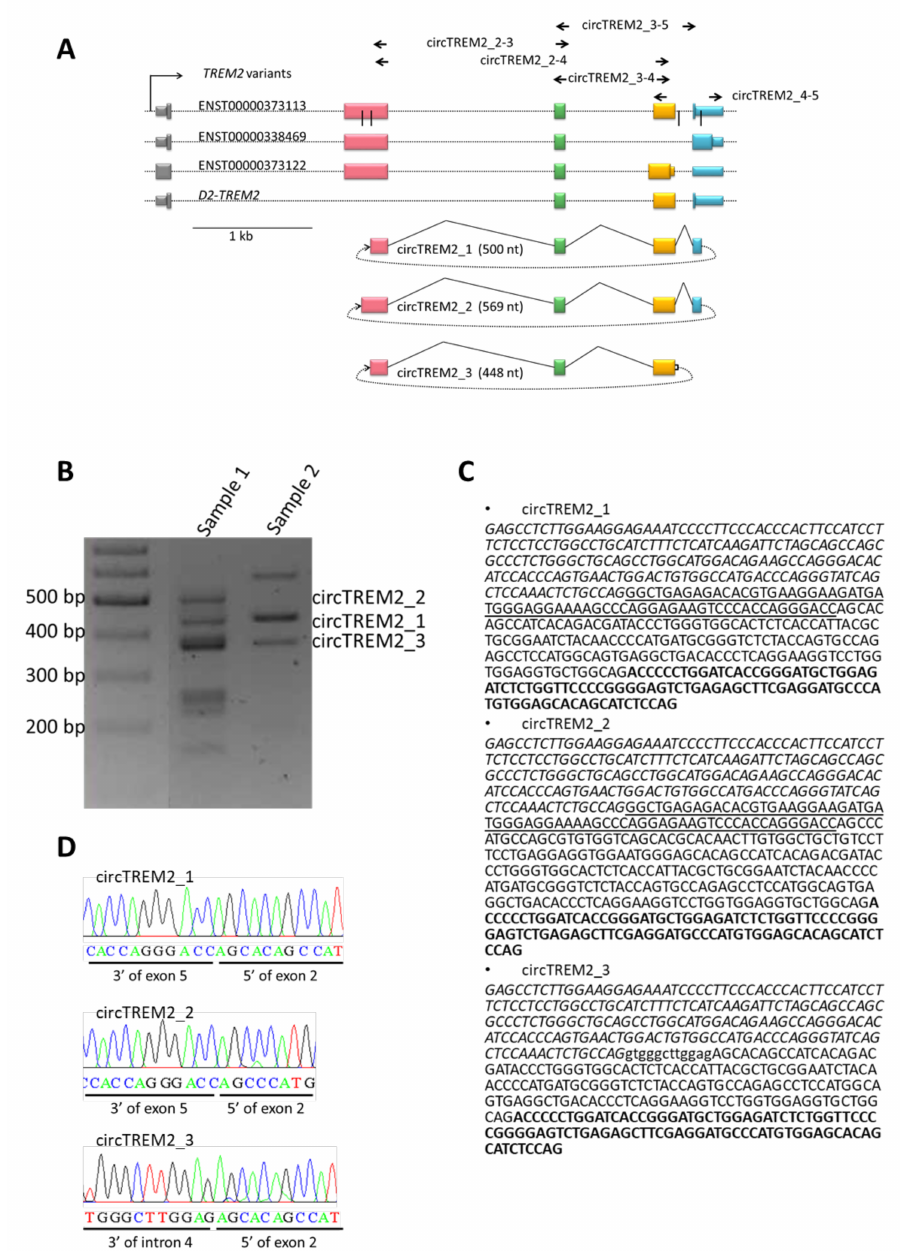
Figure 1. TREM2 and circTREM2 representation. ( A ) Gene map of linear and circular TREM2 RNA. Boxes represent exons; black vertical lines are back-splicing junction sites. Dotted lines indicated the back splicing of exons. Arrows represent set of primers used. ( B ) Representative figure of RT-PCR products of circTREM2_3-4 primer set in agarose gel. ( C ) Sequences of circTREM2s, circRNA part underlined correspond to exon 5, regular letter to exon 2, italic letter to exon 4, letter in bold to exon 3, and lower case to intron. ( D ) Electropherograms show the sequence of the junction of each circTREM2, confirming the fusion between 3’ of exon 5 and 5’ of exon 2 in the case of